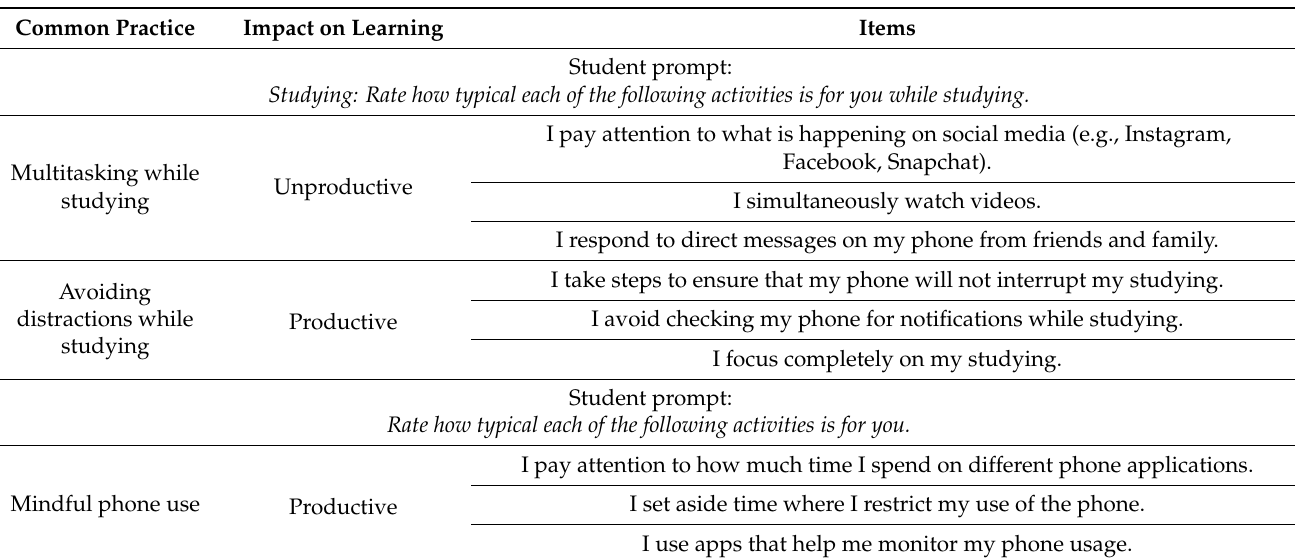
Table 3. Common phone practices.